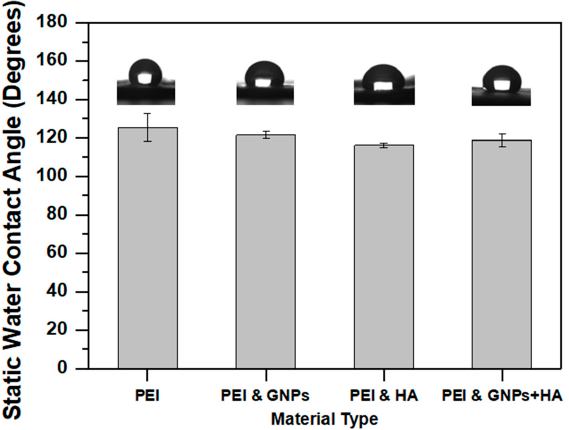
Figure 7. Bar chart diagram, providing the effect of nano-particle inclusion on the average contact angle value of the fabricated PEI scaffolds. Standard deviations (SSD) are provided.